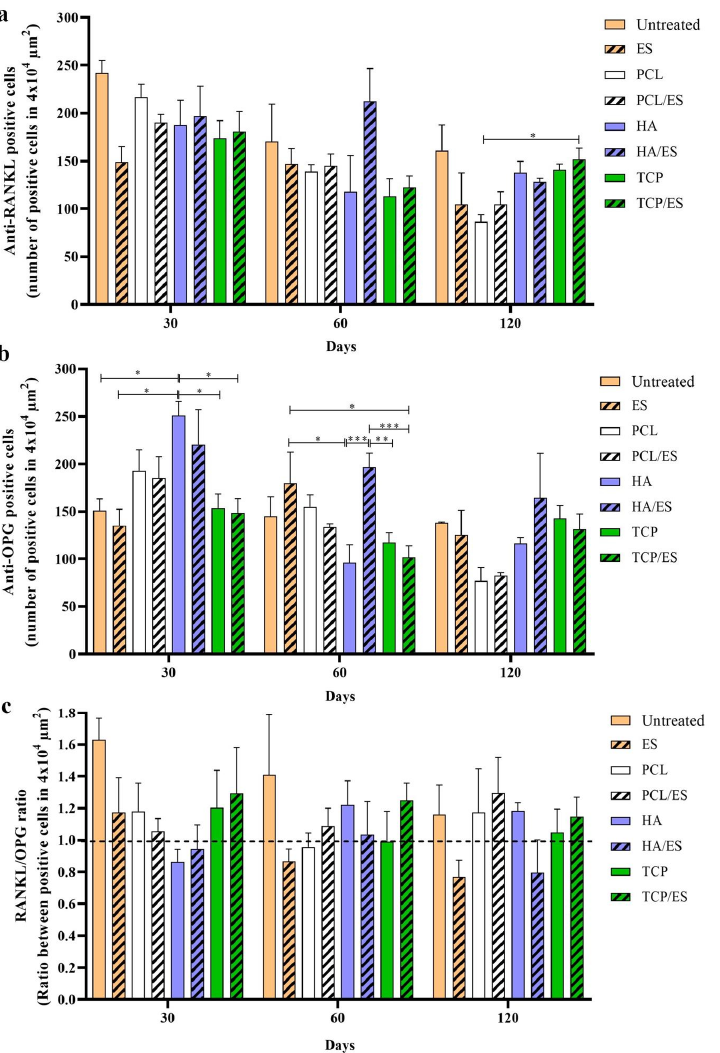
Figure 6. Evaluation of tissue remodeling by immunohistochemistry. ( a ) Quantification of anti- RANKL positive cells in 4 × 10 4 µ m 2 area in the images; ( b ) quantification of anti-OPG positive cells in 4 × 10 4 µ m 2 area in the images; ( c ) ratio of anti-RANKL and anti-OPG positive cells—values above 1.0 suggest a trend toward bone resorption, while values below 1.0 suggest tissue formation. * ( p < 0.05); ** ( p < 0.01); *** ( p <